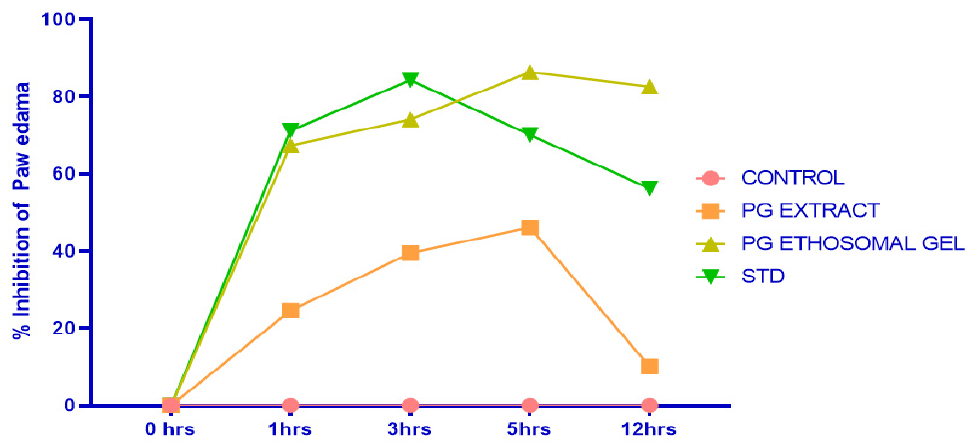
Table 6. Anti-inflammatory activity of different samples on percentage inhibition of oedema.